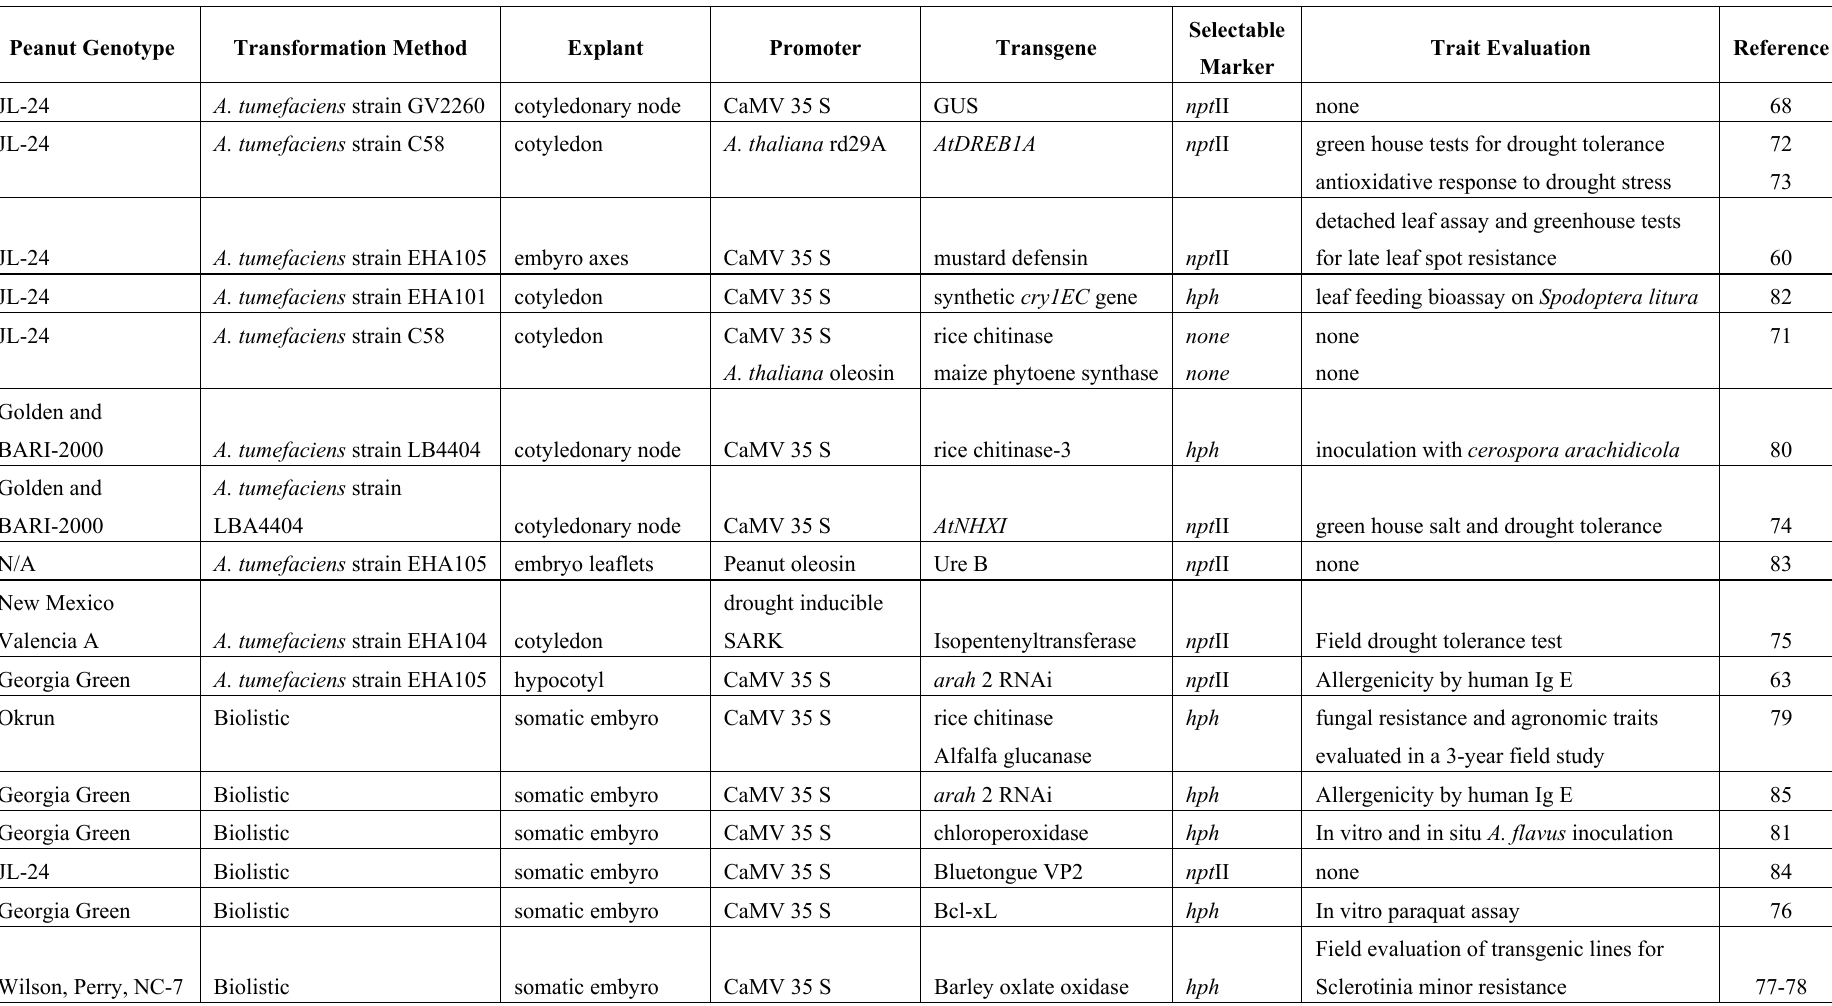
Table 1. Peanut Genetic transformation since year